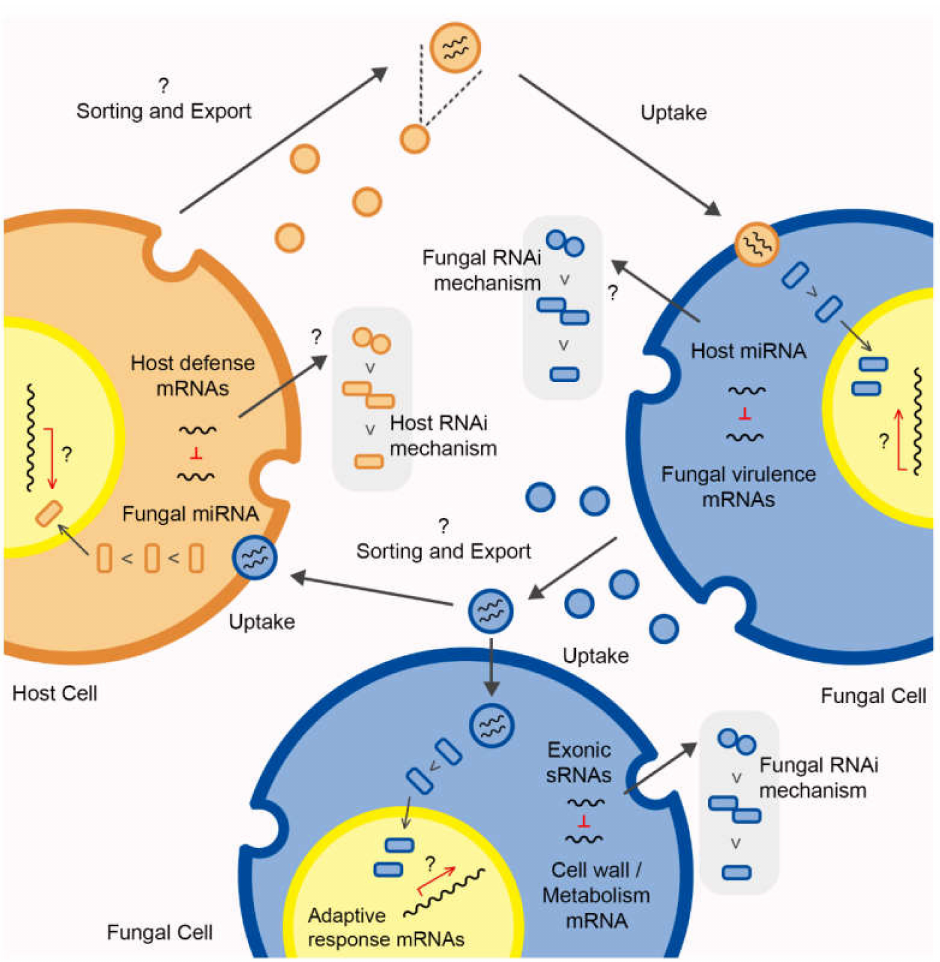
Figure 4. Extracellular vesicles’ (EVs) RNA transference between host and fungal cells via bidi- rectional communication events and intraspecies RNA transference mediated by fungal EVs. The sRNAs/miRNAs’ transference leads to target mRNA silence and, concomitantly, suggests paths able to regulate the gene expression, and affects cellular behavior in recipient cells. The question marks represent gaps that require further investigation, such as the signaling mechanisms by cells to sort molecules within EVs in response to extracellular stimuli, paths that might coordinate gene modulation after EVs uptake, and the conceivable use of RNAi machinery from recipient cells to trigger gene silencing and other regulatory